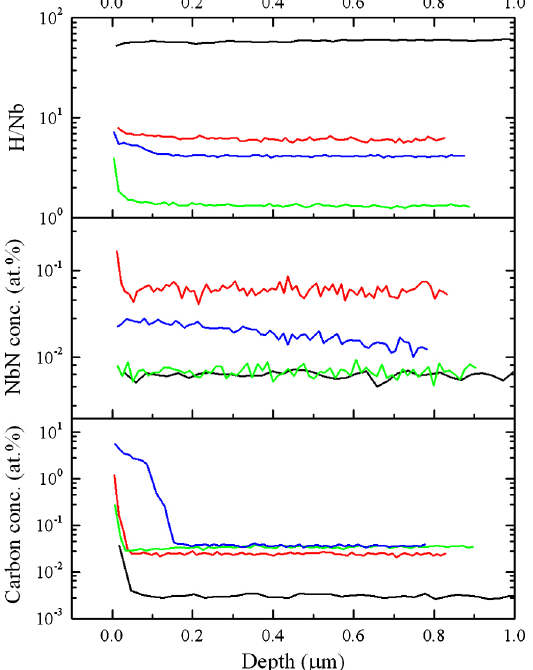
FIG. 13. H/Nb ratio, NbN and carbon concentrations measured in the reference, non-heat-treated, sample L35 (black line), sample L40 heat treated at 1000 (cid:1) C (red line), sample L48 heat treated at 1200 (cid:1) C (green line), and sample L51 heat treated at 1400 (cid:1) C (blue line). 60 (cid:1) m detected area, and a mass resolution of 2000 were used for Cs þ beam, whereas a current of 20 nA, a raster area of 220 (cid:1) m (cid:2) 220 (cid:1) m with 60 (cid:1) m detected area, and a mass resolution of 2200 were used for O þ beam. SIMS 2